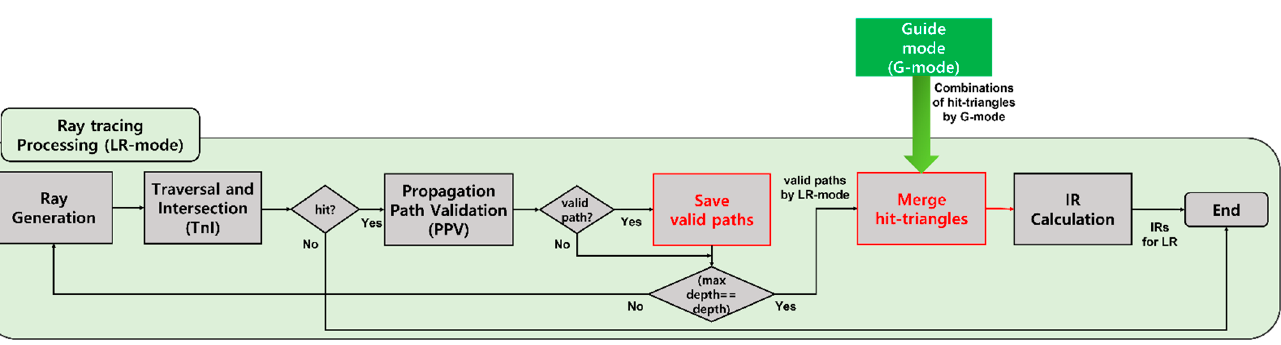
Figure 9. Flowchart of LR mode for one sound source modified to suit the multi-threaded method: new steps (red boxes).